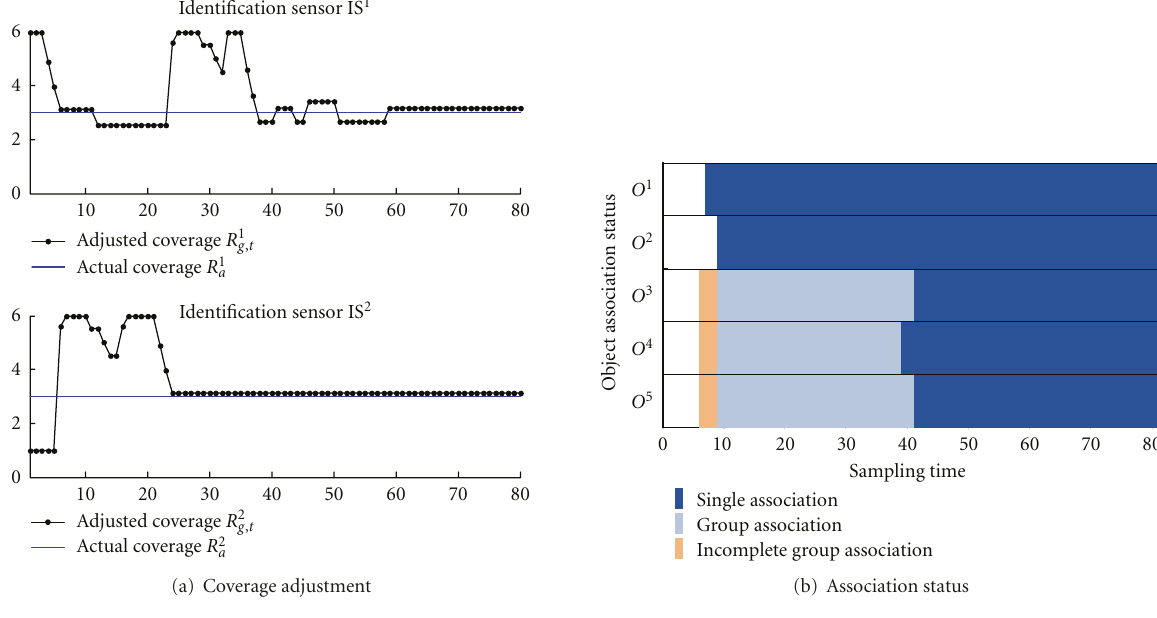
Figure 11: Simulation result of coverage adjustment and association status for Figure